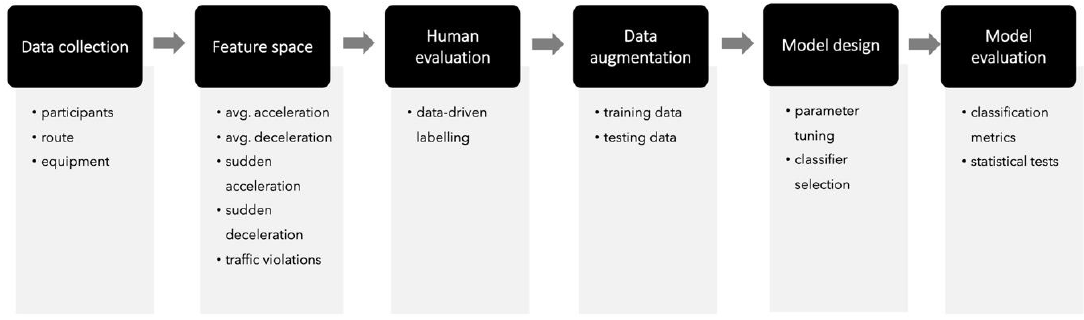
Figure 1. Proposed six-step methodology for driving-style classification.